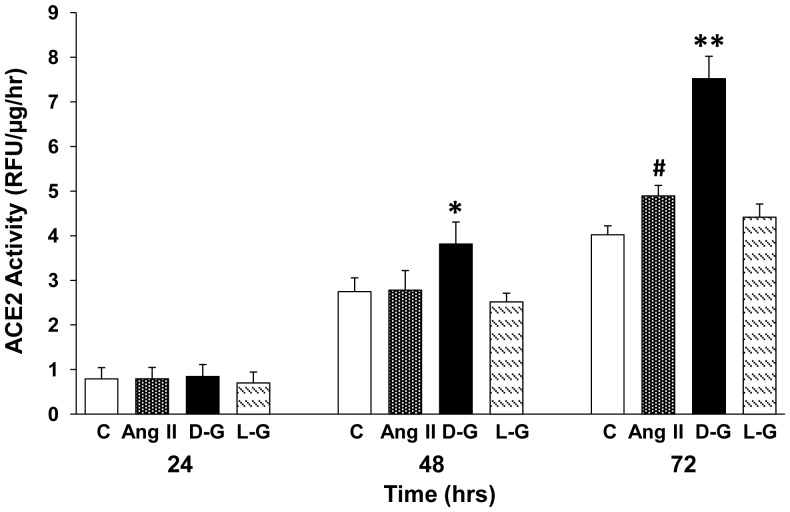
ACE2 shedding is stimulated by high D-glucose or Ang II in mouse PT cells.Primary cultures of mouse PT cells were incubated for 24, 48 and 72(C, 7.8 mM D-glucose), with Ang II (10−7 M) or in high D-glucose (D-G, 25 mM) media. As a control for osmolality, some cells were incubated with L-glucose (L-G, 25 mM). ACE2 activity in the media was assayed at each time point. *p<0.001 vs L-G, p<0.004 vs C, p<0.025 vs Ang II, all at 48 hrs, n = 7–9. **p<0.001 vs all 3 other groups at 72 hrs, n = 14–18. #p< 0.04 vs C at 72 hrs, n = 14–18.